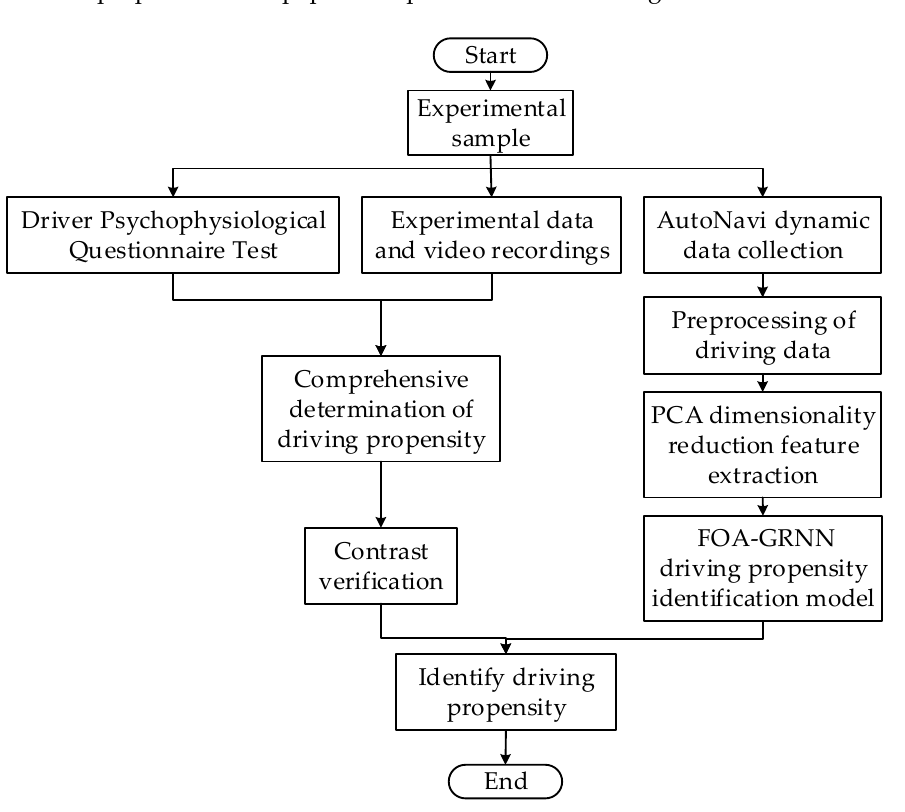
Figure 8. Flow chart of the driving propensity identification method.